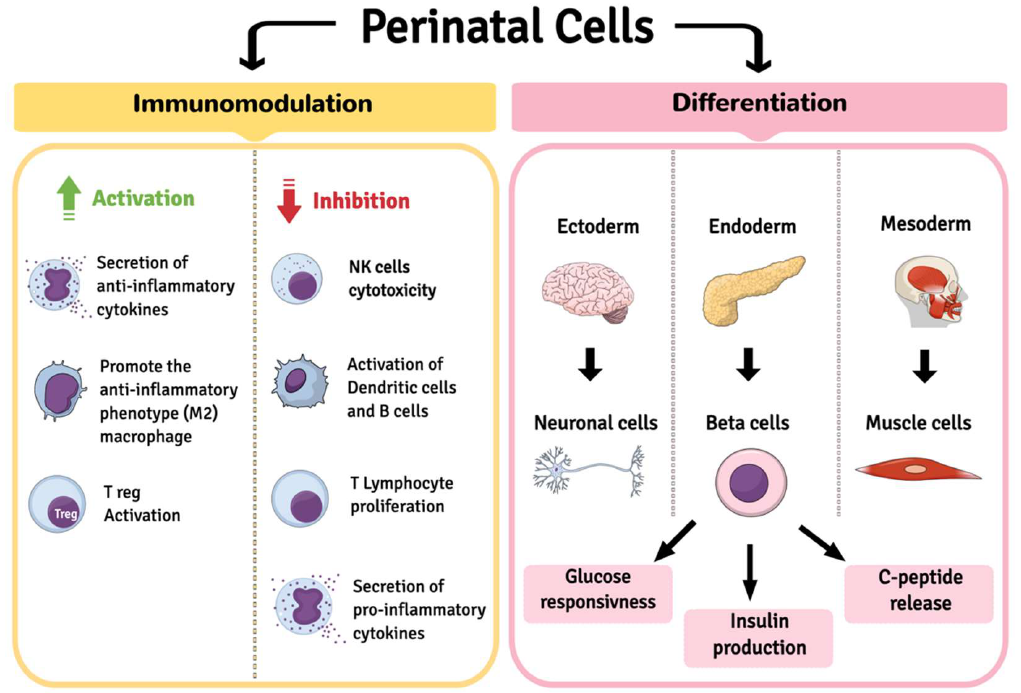
Figure 1. The double ability of perinatal cells in sustaining anti-diabetes cell therapy strategies. One activity of perinatal cells is to promote anti-inflammatory effects and to regulate pro-inflammatory response, both by using their own secretome and by interacting with different immune cells. In addition, the cell ability to differentiate, particularly into the endoderm lineage, makes perinatal cells ready to be exploited during directed or induced differentiation towards beta cell commitment, pre-transplantation or post-transplantation. The limiting activity on patient auto-immune response and the new production and release of insulin in vivo are expected to be one of the chief challenges in regenerative medicine for diabetes treatment. Table 1. The immunomodulatory capacity and differentiation potential of perinatal cells reviewed in this study.